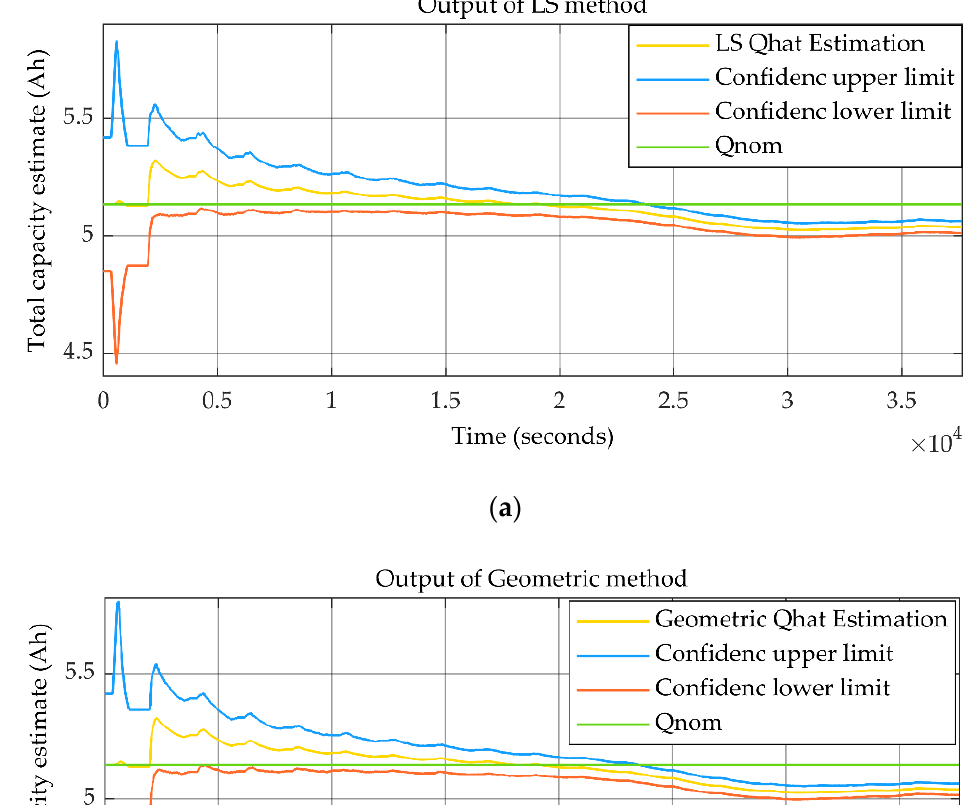
Figure 8. Total Q estimation diagram.